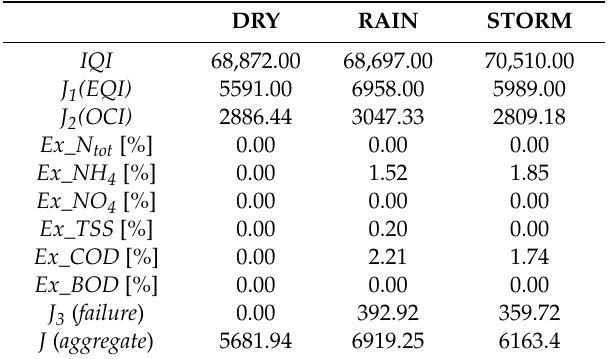
Table 5. Performance criteria in the three operating regimes of the treatment